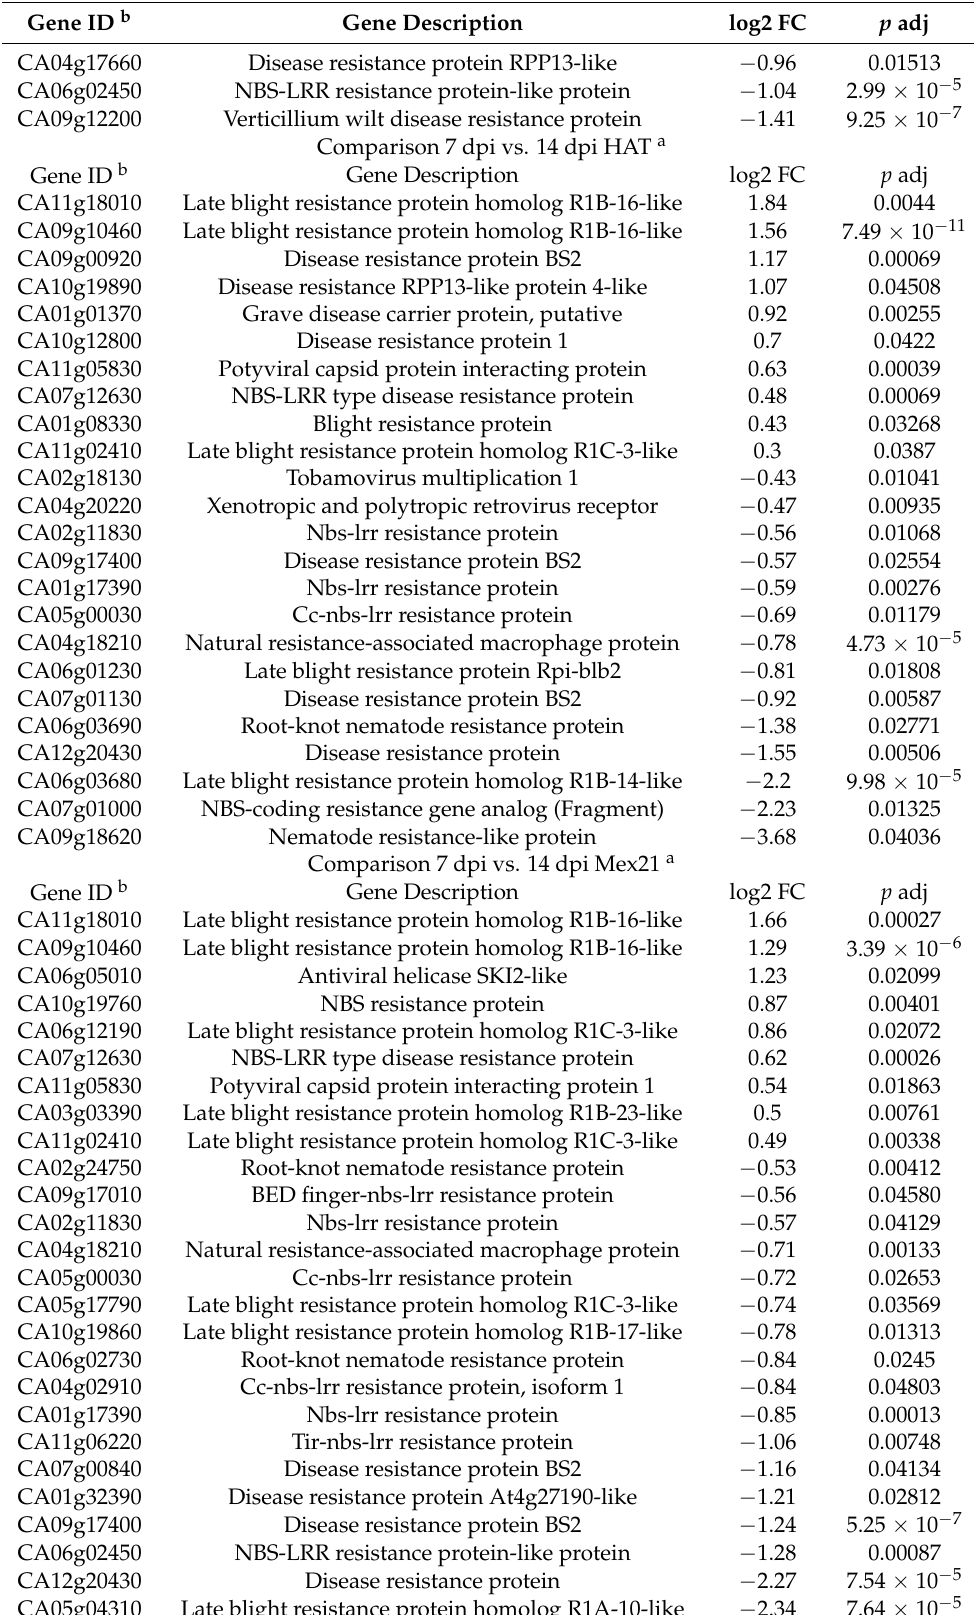
Table 3. Cont. Comparison 7 dpi vs. 14 dpi Buffer-Mock Control a